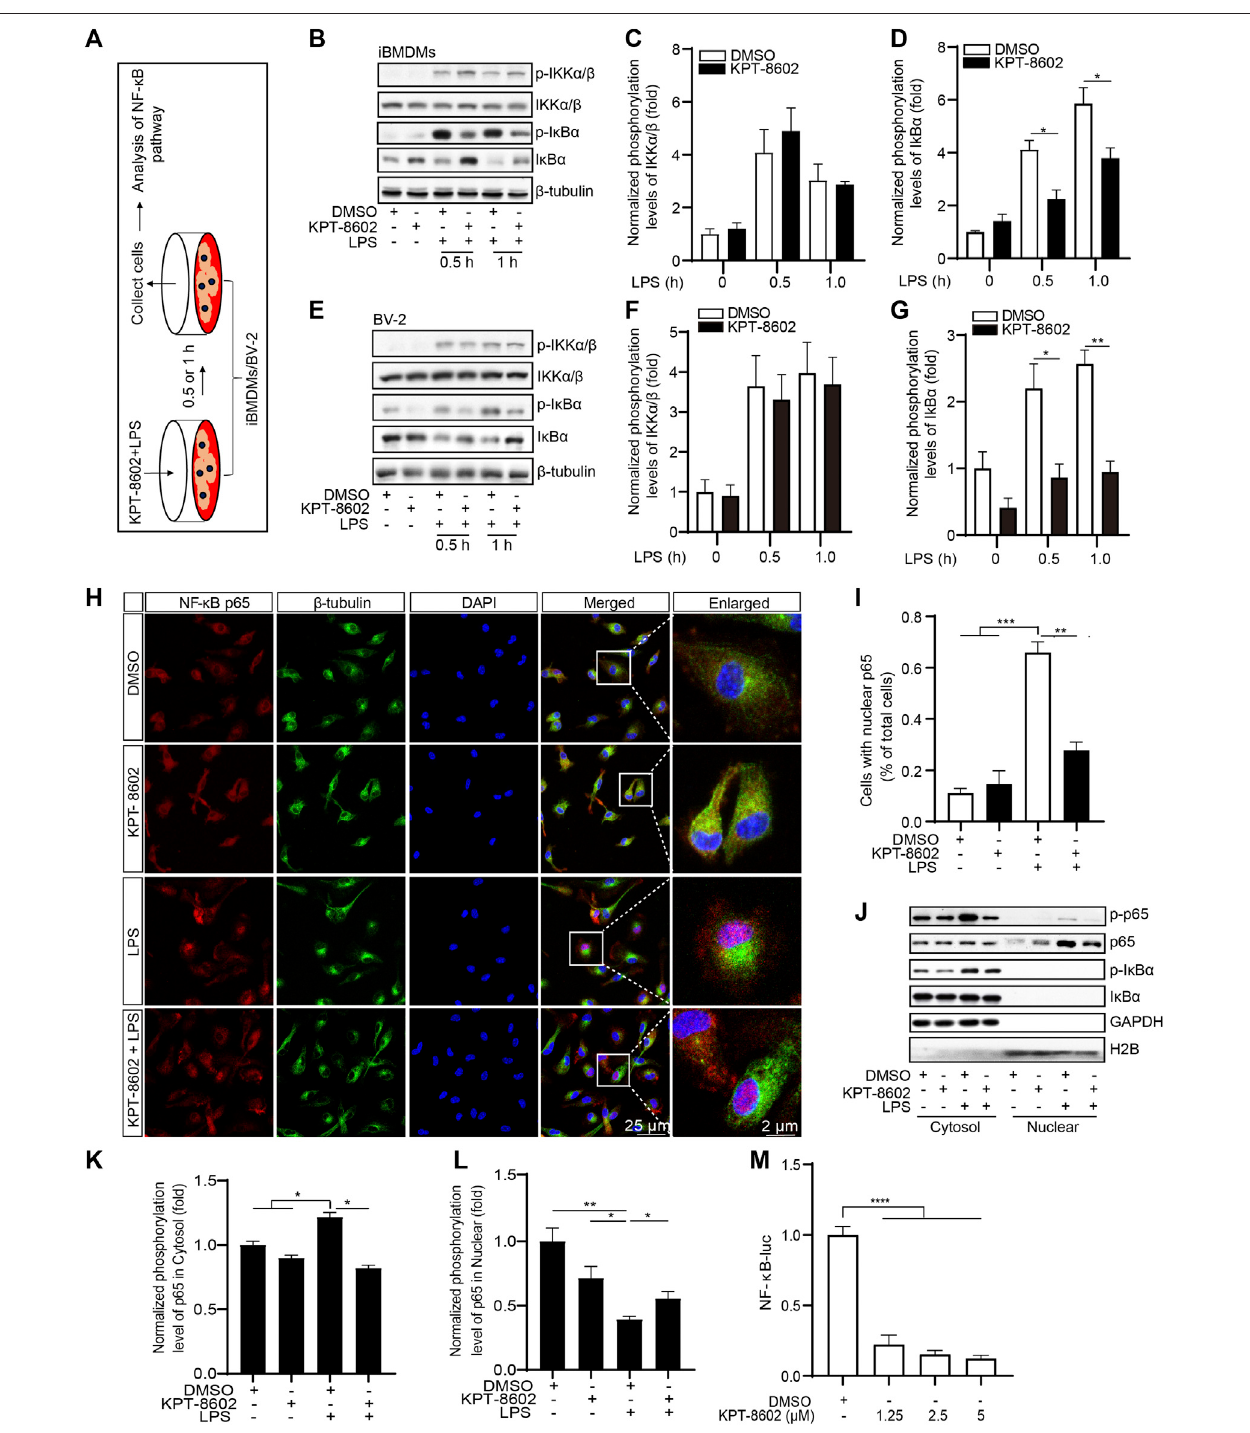
FIGURE 3 | KPT-8602 inhibited LPS-induced activation of the NF- κ B signaling pathway. (A) iBMDMs or BV-2 were pretreated with or without KPT-8602 (5 μ M) and stimulated with LPS for 0.5 and 1 h, respectively, and then the cell lysates were collected for analysis by Western blotting (B,E) . The gray values of the phosphorylated and total IKK α / β (C,F) and I κ B α (D,G) bands were analyzed with ImageJ. (H,I) PMs were pretreated with KPT-8602 for 30 min and stimulated with LPS for 2 h. Then, the cells were fi xed and stained with a rabbit anti-NF- κ B p65 antibody and mouse anti- β -tubulin antibody (H) , and the number of cells containing nuclear p65 was analyzed by ImageJ (I) . Scale bars, 25 μ m for low-magni fi cation images and 2 μ m for high-magni fi cation images, respectively. (J,K) iBMDMs were pretreated with KPT-8602for 1 h and stimulated with LPSfor 2 h, and then extracts from the nucleus and cytoplasm were collected foranalysisbyWesternblotting (J) . Thegrayvalueofthephosphorylatedandtotalp65inthenucleus (K) andcytoplasm (L) wereanalyzedwithImageJ.H2Bservedasanuclearproteinmarker;GAPDHas a cytosolic protein marker. (M) Quantitative analysis of the effect of KPT-8602 on NF- κ B luciferase activity. (* indicates p < 0.05, ** indicates p < 0.01, *** indicates p < 0.001, **** indicates p < 0.0001 by one-way ANOVA).